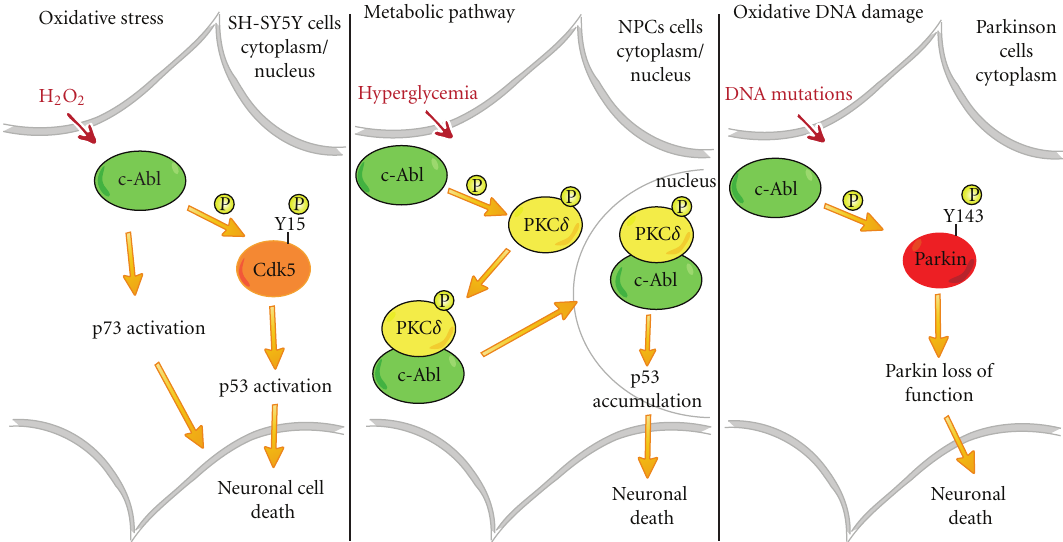
Figure 1: The figure illustrates the involvement of c-Abl in many cellular stress pathways. Oxidative stress, hyperglycemia, and DNA damage response induce c-Abl activation. In human neuroblastoma (SH-SY5Y cells), c-Abl targets p73, promoting neuronal death in response to hydrogen peroxide. In addition, c-Abl can also phophorylate Cdk5 and in tandem with Cdk5 can mediate p53 activation, promoting neuronal death. Hyperglycemia-induced apoptosis of NPCs is mediated by the translocation of the PKC δ -Abl complex to the nucleus. This translocation impacts on p53 activation leading to neuronal death. Oxidative DNA damage in Parkinson disorder is associated with increased c-Abl activity. c-Abl mediates tyrosine phosphorylation of Parkin and inhibits parkin’s ubiquitin E3 ligase